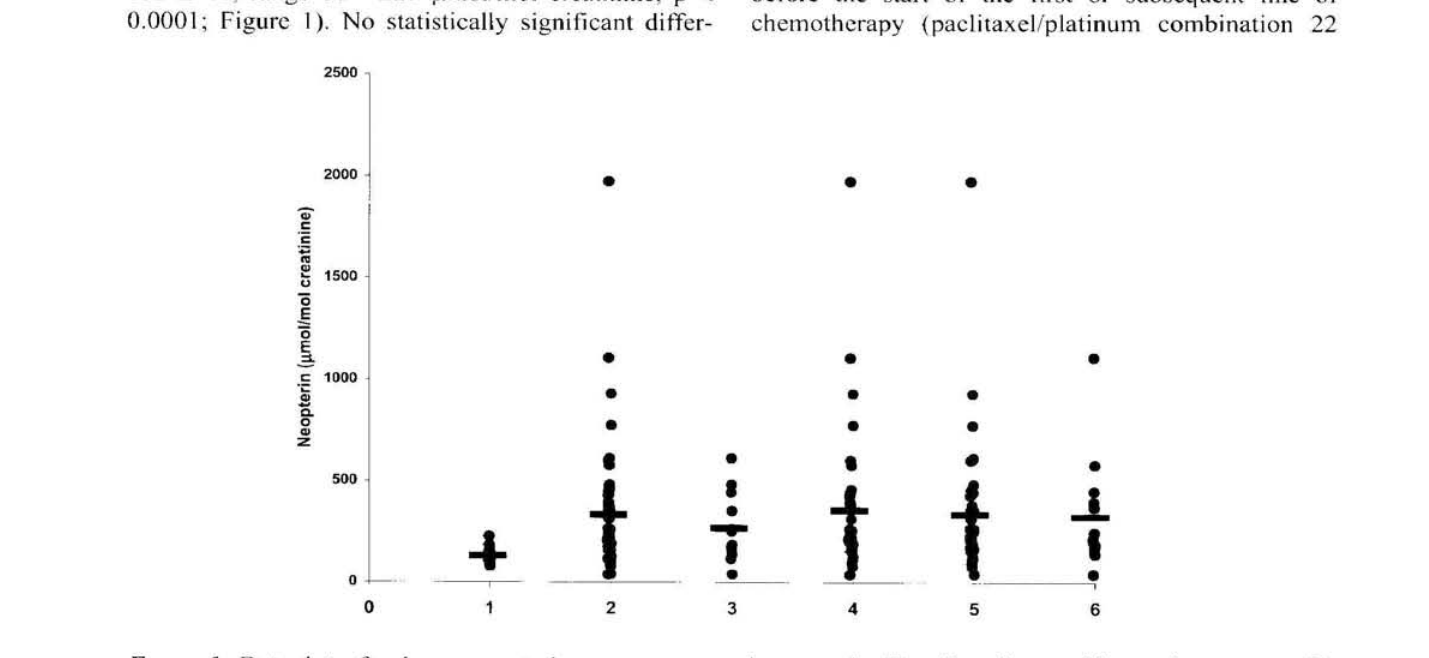
Fgure 1. Dot plot of urinary neopterin measurements in controls (1), all patients with ovarian cancer (2), chemotherapy-naive patients (3), pretreated patients (4), patients with primary ovarian cancer (5) and patients with ovarian metastases of other primary tumors (6); horizontal lines indicate mean